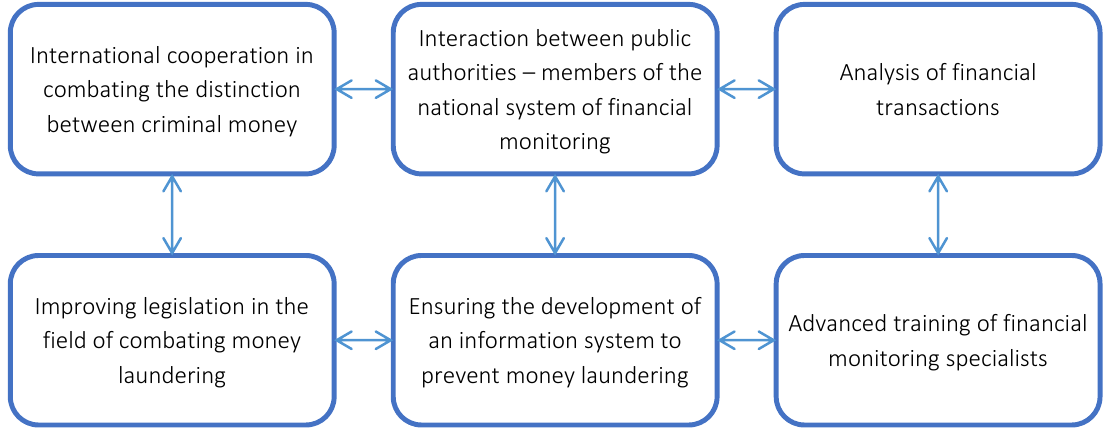
Figure 1. Anti-money laundering